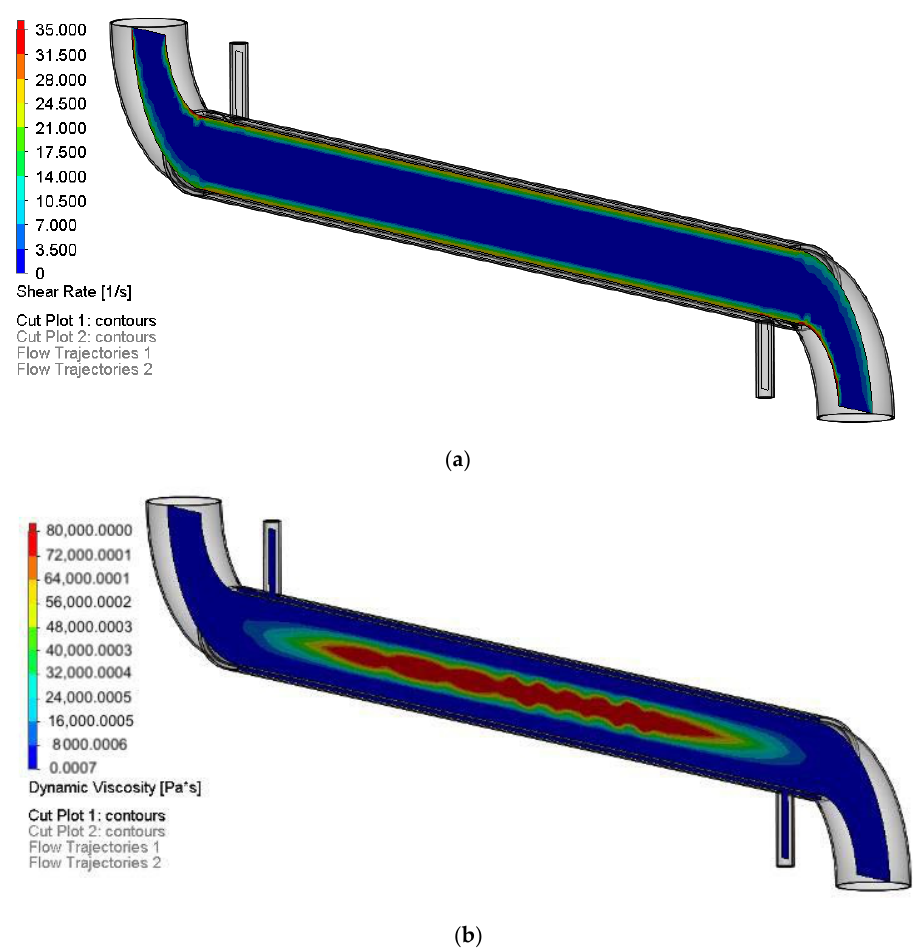
Figure 7. Shear rate ( a ) and dynamic viscosity ( b ) inside the heat exchanger with a paste flow rate of 3000 kg/h.